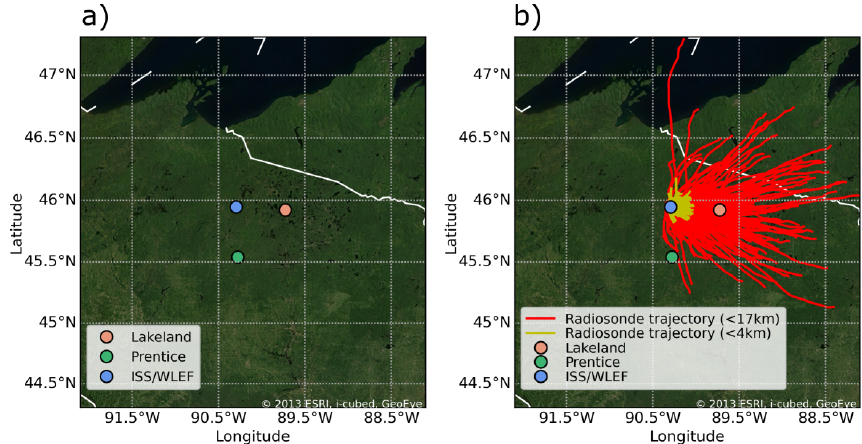
Figure 1. (a) Location of the four measurement sites where instruments were deployed to examine PBL structure and evolution during the CHEESEHEAD19 field campaign. The background shows aerial imagery. Since the ISS and WLEF sites were located less than 2km apart, they are plotted with the same marker. (b) Trajectories of all the radiosondes released from the ISS facility (red up to 17kma.g.l. and yellow up to 4kma.g.l.) are shown. Table 1. List of instruments used in this study, with site and time of the deployment during CHEESEHEAD19 and information indicating the analysis time periods. Instrument system Deployment Deployment Used in the Used in the Used in the locations period multi-month Summer-IOP Fall-IOP time period analysis analysis